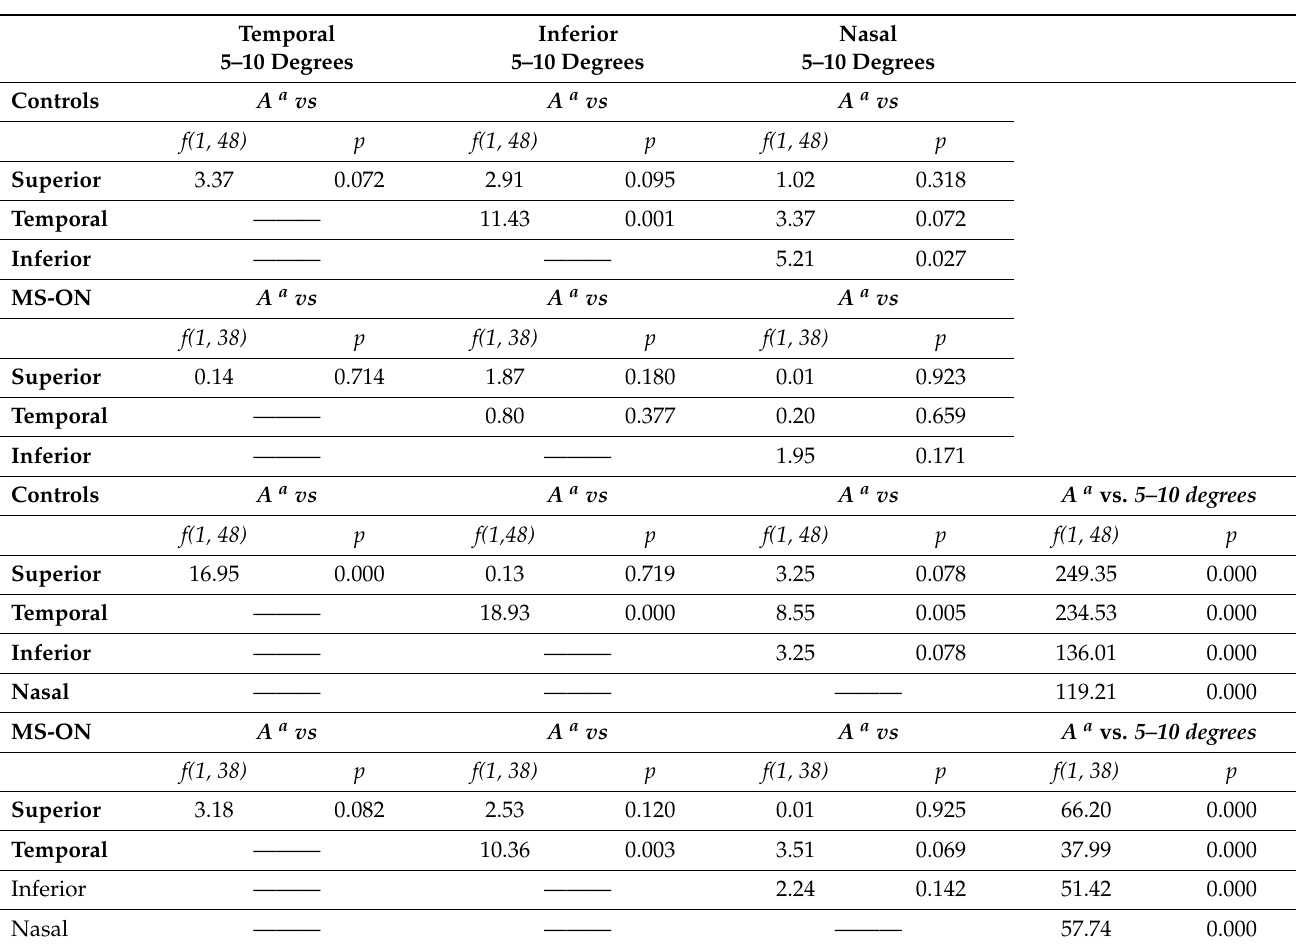
Table 6. Statistical differences between different localized retinal areas of multifocal photopic